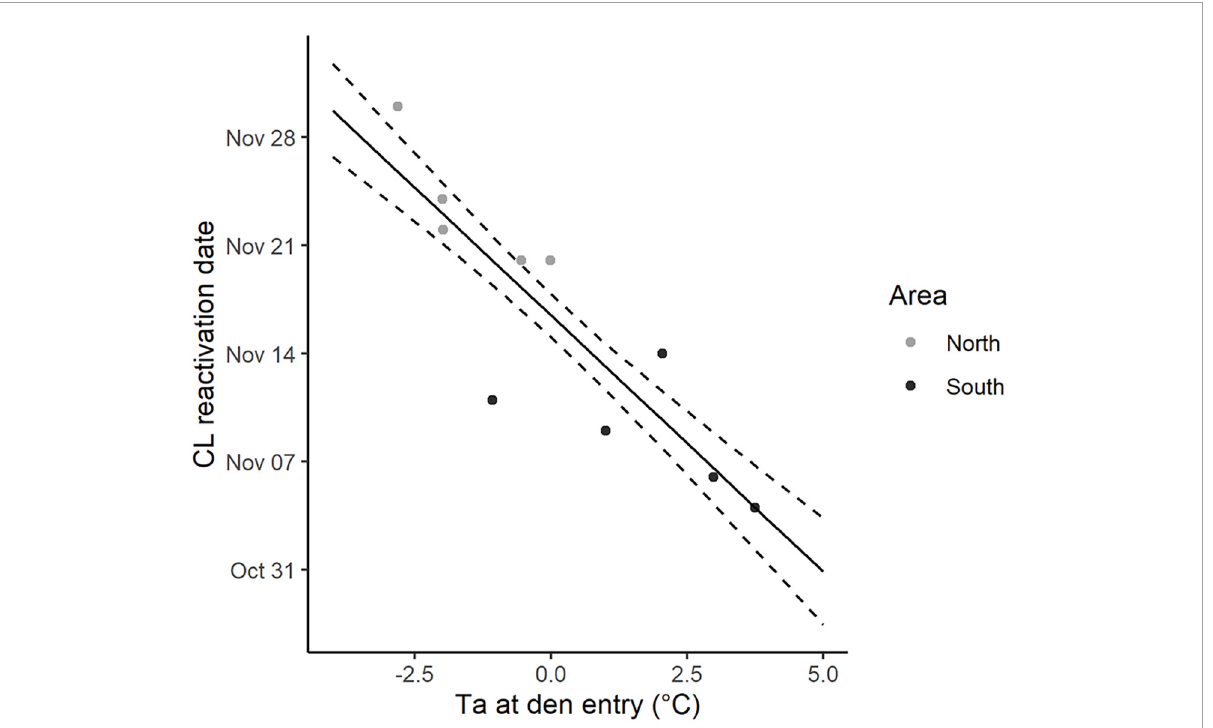
FIGURE3 Dates of corpus luteum (CL) reactivation for pregnant female Scandinavian brown bears from two study areas in Sweden along the gradient of ambient temperature (T a , ◦ C) at den entry from 2011 to 2017. Observed values (filled dots) are colored according to the study area (northern area: light gray, N = 5; southern area: dark gray, N = 5). Predicted values (solid lines) are shown irrespective of the study area. Dashed lines represent the 95% confidence interval.